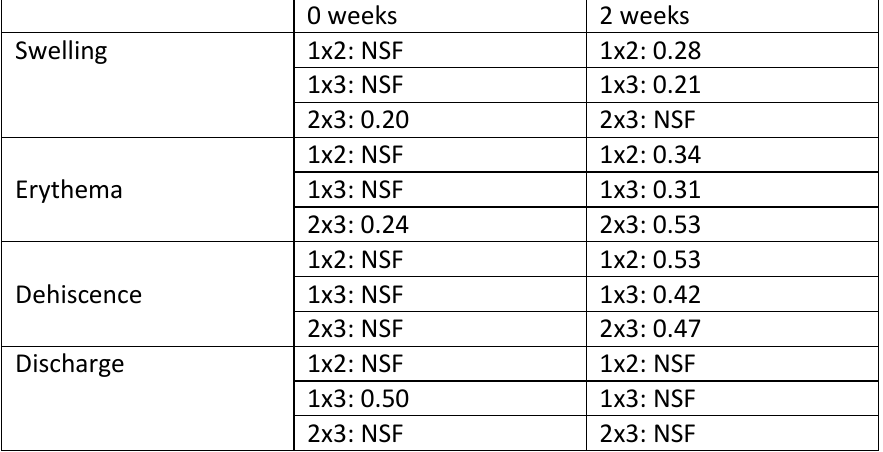
Table 3: Kappa Statistic for the Components of the Composite Score to Evaluate Inter-rater Reliability between Vet surgeons. This statistic is used to demonstrate the reliability of non-parametric data and compares only 2 observers at a time. Therefore, 1x2 signifies observer 1 compared to observer 2 and 2x3 signifies observer 2 compared to observer 3 etc. If p<0.05, no significant finding (NSF) was